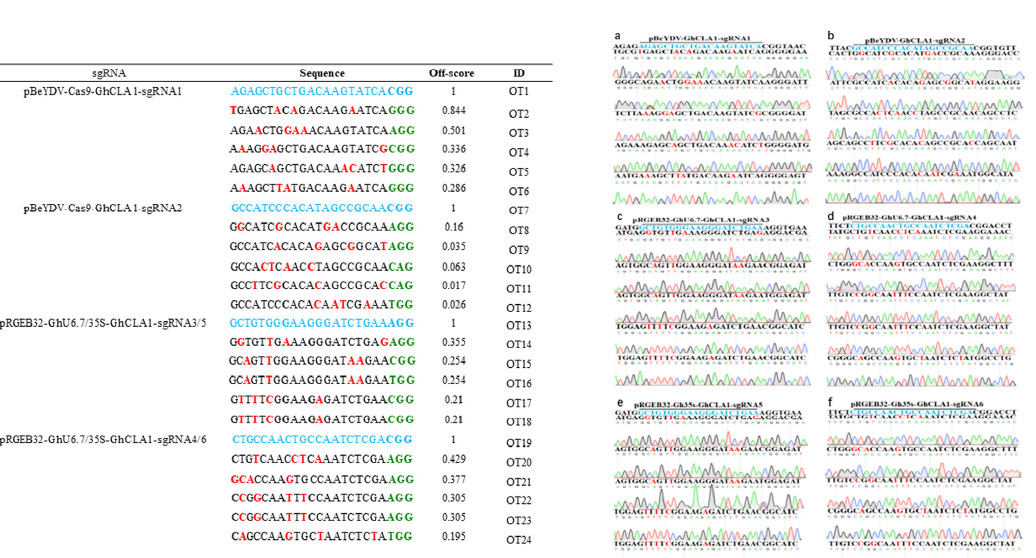
Figure 5. Frequencies of deletions of different sizes at different target sites by three different systems. ( a ): pBeYDV-Cas9-GhCLA1-sgRNA1. ( b ): pBeYDV-Cas9-GhCLA1-sgRNA2. ( c ): pRGEB32-GhU6.7-GhCLA1-sgRNA3. ( d ): pRGEB32-GhU6.7-GhCLA1-sgRNA4. ( e ): pRGEB32-35S-GhCLA1-sgRNA5. ( f ): pRGEB32-35S-GhCLA1-sgRNA6. PAM is underline. The experiments were carried out in cotton T0 plants and frequencies were measured by Hi-Tom sequencing.